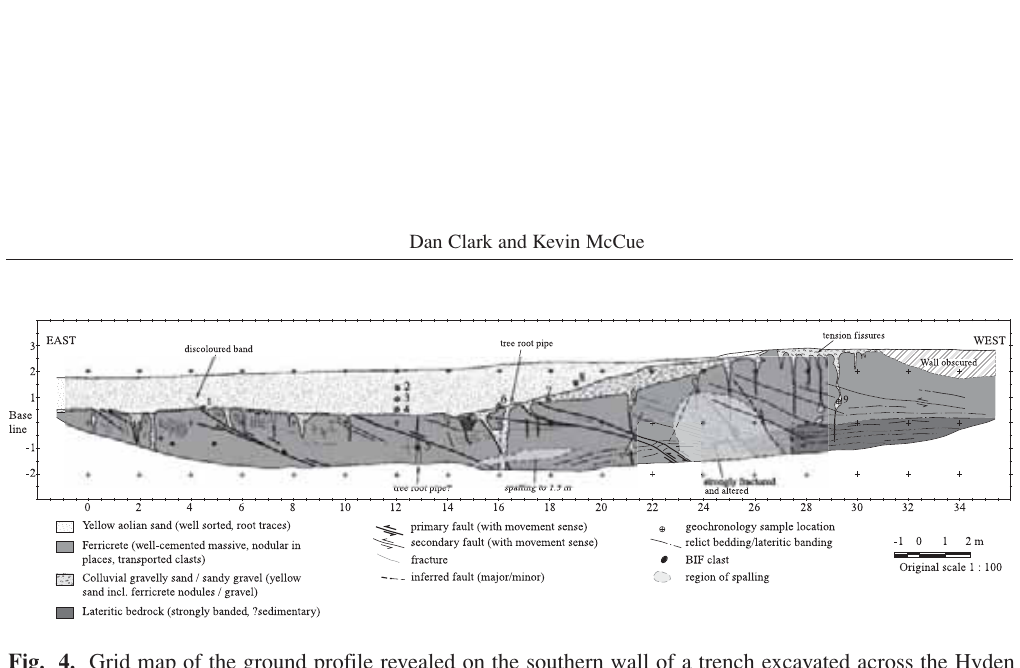
Fig. 4. Grid map of the ground profile revealed on the southern wall of a trench excavated across the Hyden scarp in Western Australia (after Clark et al .,